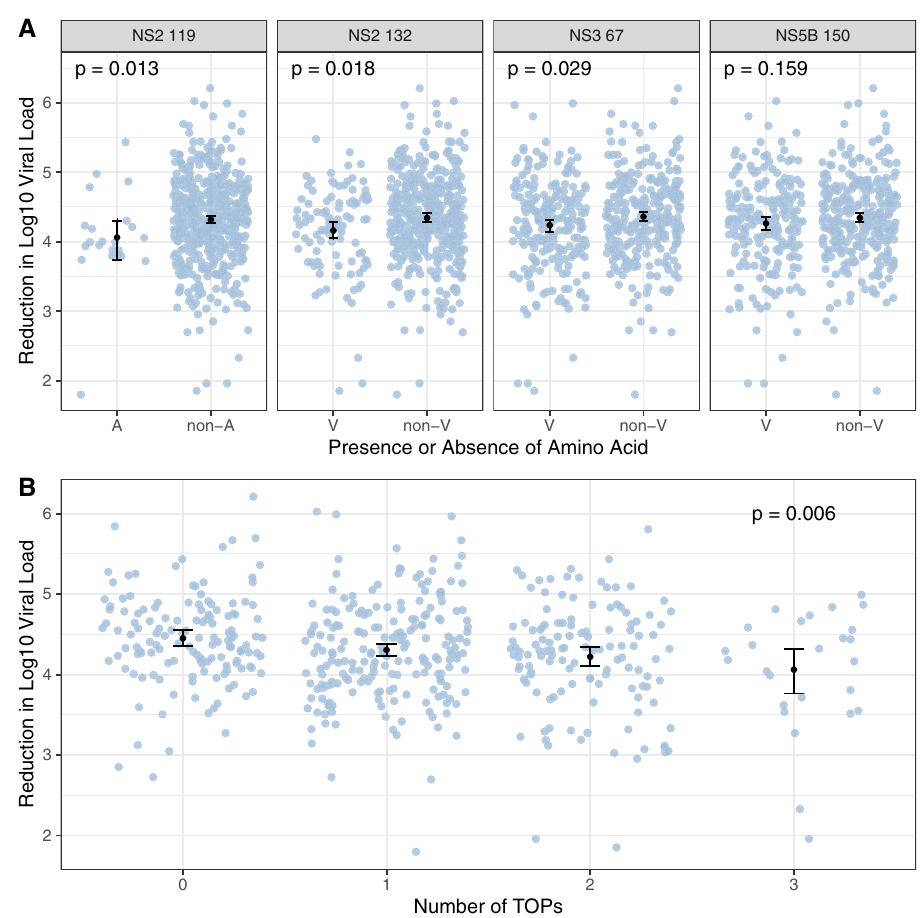
Fig. 3 Reduction in viral load during the fi rst week of therapy and its association with treatment outcome polymorphisms (TOPs). A Reduction in log10 viral load between baseline and week one of therapy strati fi ed by presence and absence of the residue associated with the lowest SVR rate at each TOP (A: Alanine, non-A: any amino acid other than alanine, V: Valine, non-V: any amino acid other than Valine). n = 507 patients. The mean change in viral load is shown as a black dot for each TOP and the lines indicate its 95% con fi dence intervals. P -values for difference in mean calculated using one-sided Mann – Whitney test. B Reduction in log10 viral load between baseline and week one of therapy against increasing numbers of TOPs (presence or absence of residue associated with the lowest SVR rate at the target sites). n = 507 patients. The mean change in viral load is shown as a black dot and the lines indicate its 95% con fi dence interval. P -value for association between number of TOPS and reduction in log10 viral load calculated using linear regression.